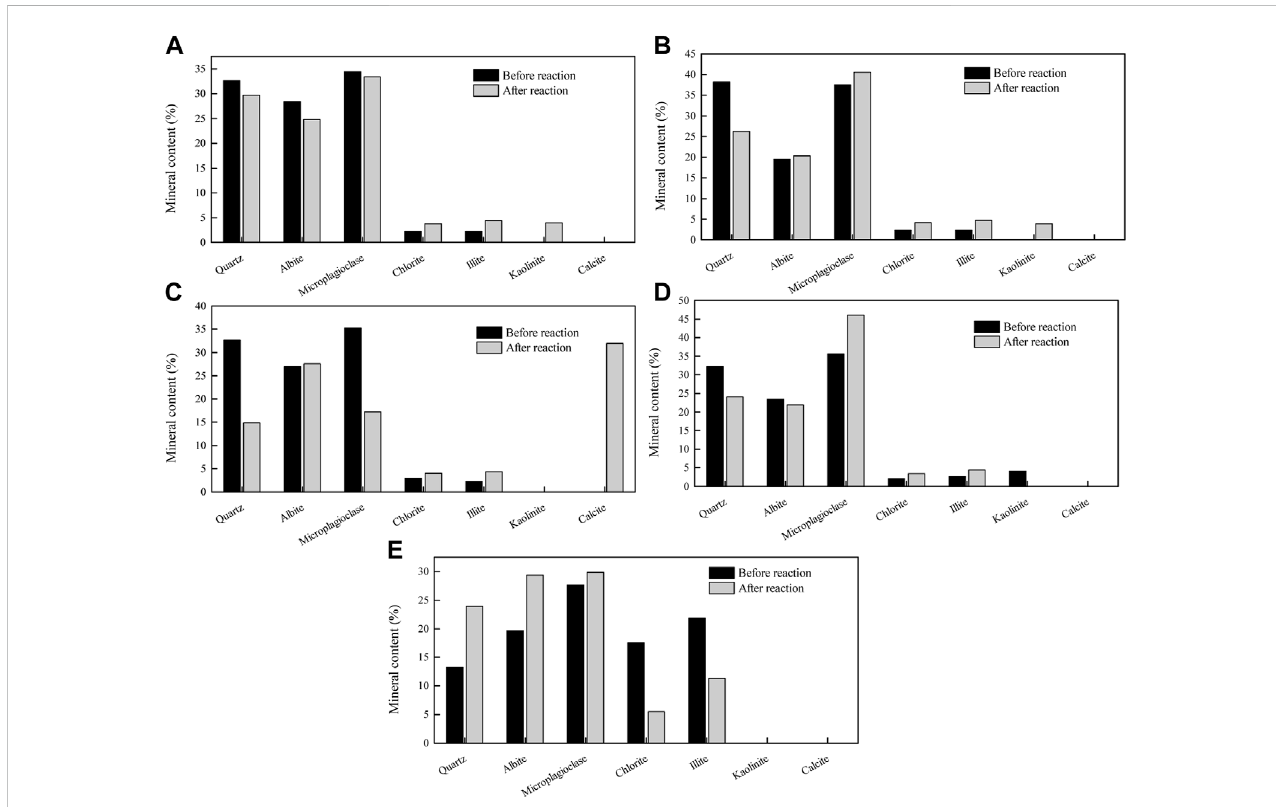
FIGURE 4 Changeinthemineralcontentofsamplesbeforeandafter theCO 2 +O 2 – water – rockgeochemicalreaction: (A – E) representthesamplesCS,ZS,XS,FS, and